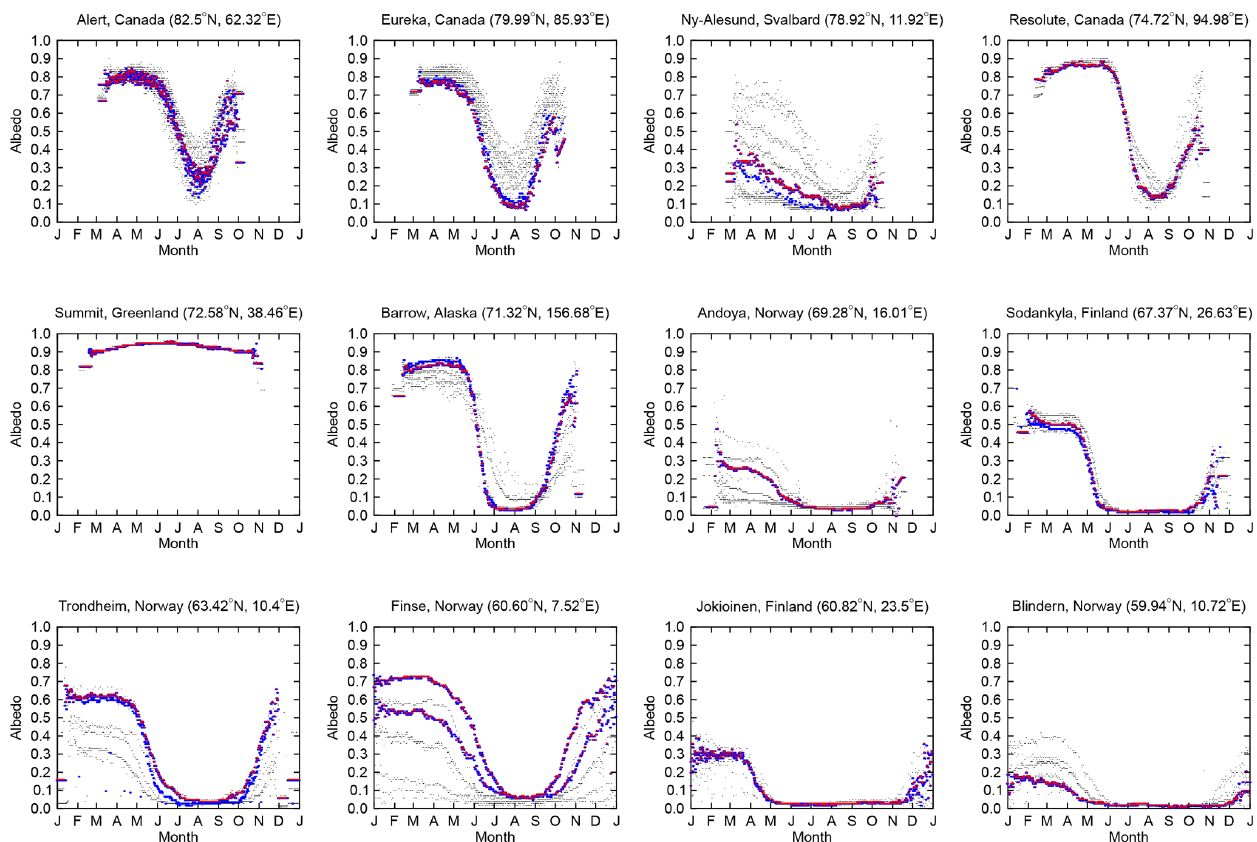
Figure 3. Surface albedo (SufAlbedo) of the OMI albedo climatology for each site, extracted from the OMI data files. Black symbols indicate all available data. Blue symbols indicate data where the distance (parameter “Dis”) between the location of the stations and the center of the OMI pixel is smaller than 12km. For red symbols, Dis is smaller than